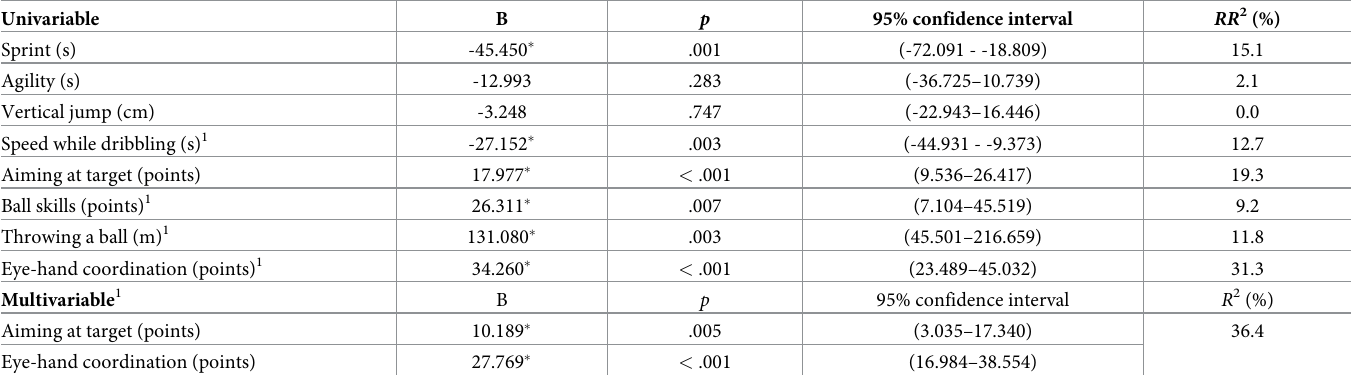
Table 2. Multilevel analysis for predictive value of the perceptuo-motor skills assessment on competition